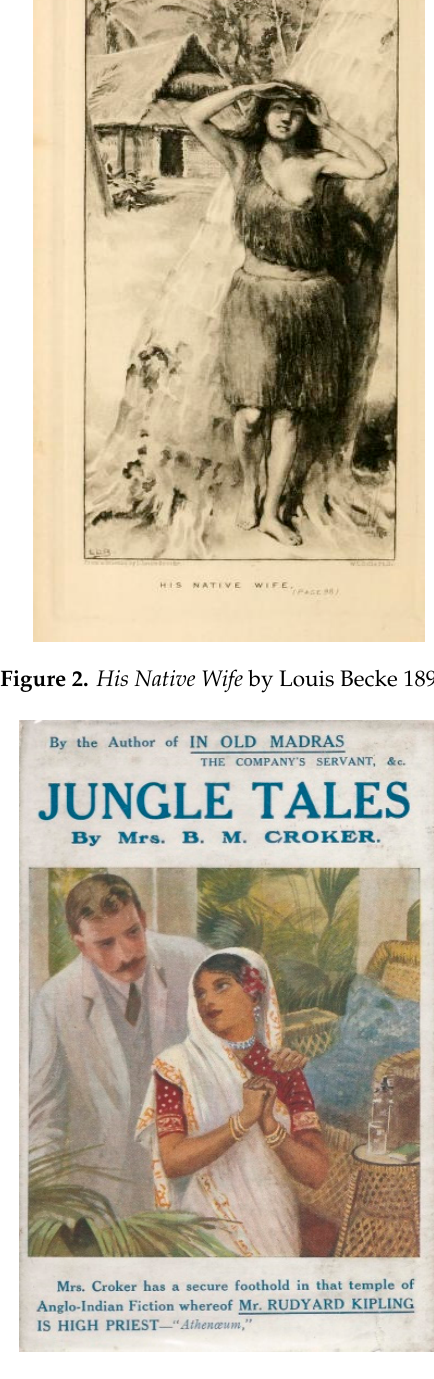
Figure 3. Jungle Tales by B.M. Croker 1913.